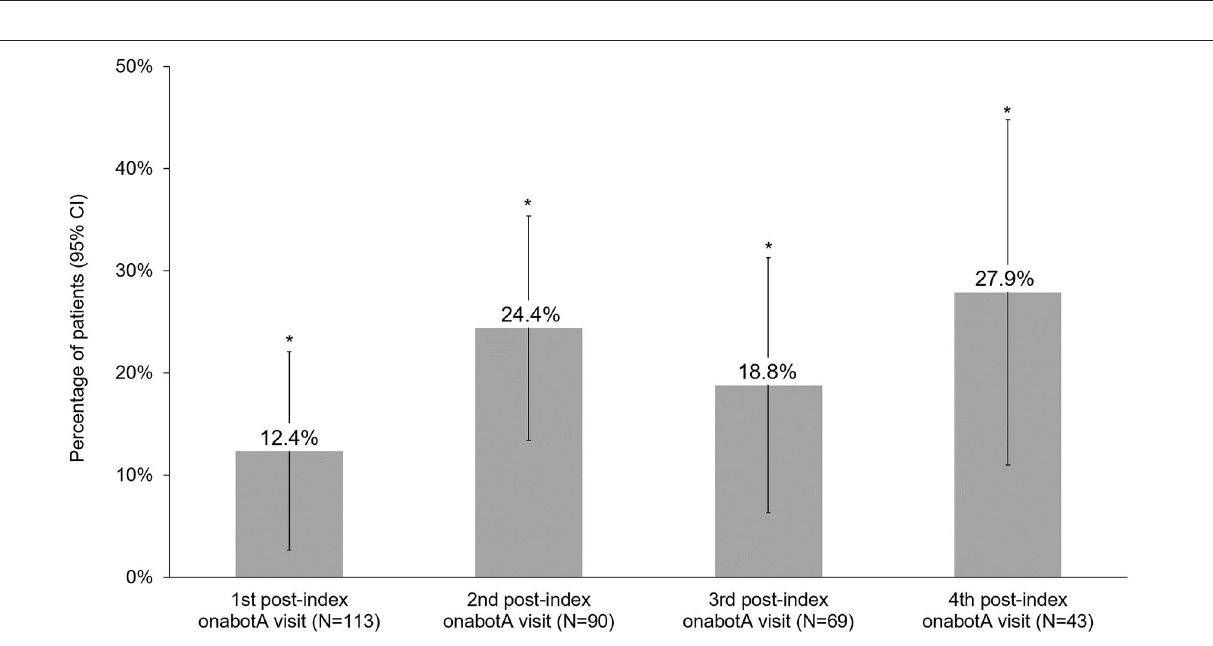
FIGURE 5 | Proportion of patients who achieved controlled chronic migraine ( < 15 headache days/month) status on combination treatment with onabotulinumtoxinA and CGRP mAb. CGRP, calcitonin gene-related peptide; CI, confidence interval; mAb, monoclonal antibody; onabotA, onabotulinumtoxinA. *Indicates statistical significance (i.e., 95% CI does not include